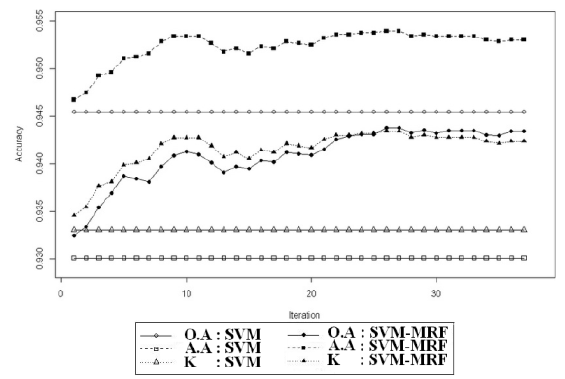
Figure 5. Overall accuracy (O.A), average accuracy (A.A) and kappa coefficient (K) for SVM method and SVM-MRF method according to iterations of S.A method